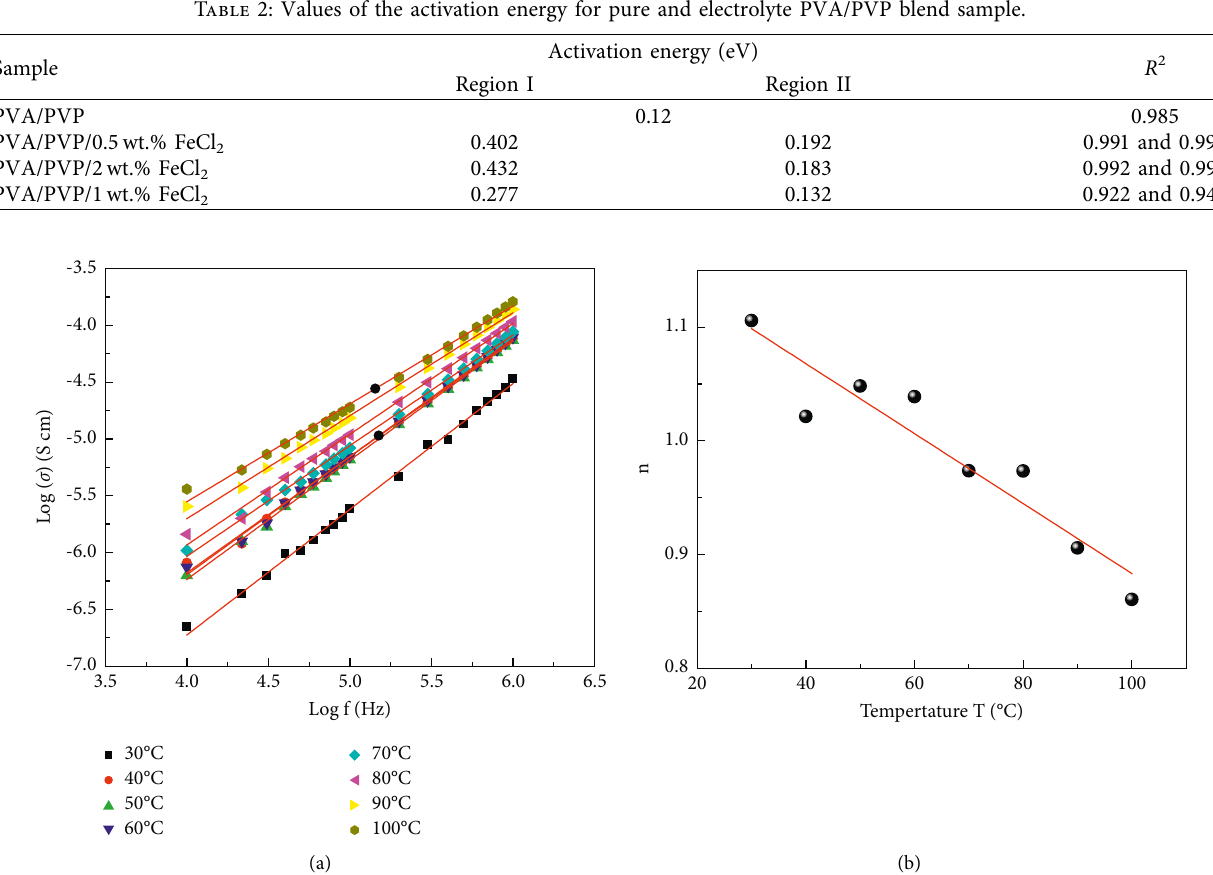
Figure 15: (a, c) log σ versus log f at different temperatures and (b, d) variation of the exponent n against the temperature, for the PVA/PVP